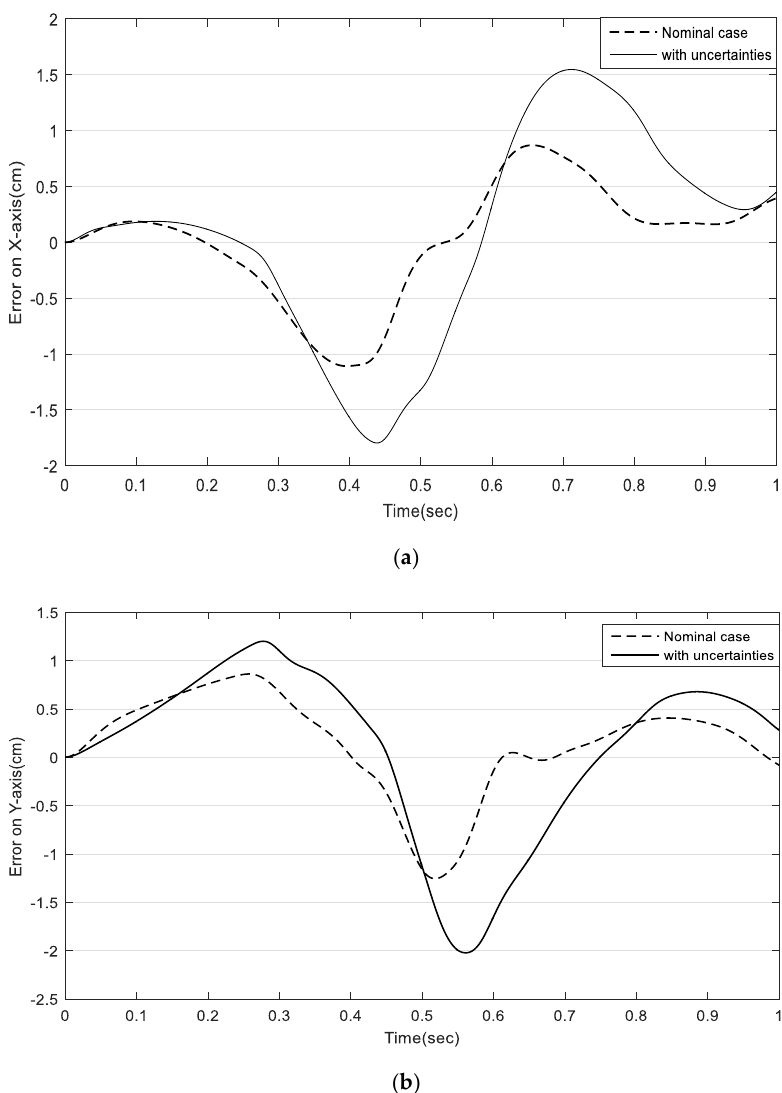
Figure 13. Effect of model uncertainties on CTC tracking errors: ( a ) X-axis; ( b ) Y-axis.